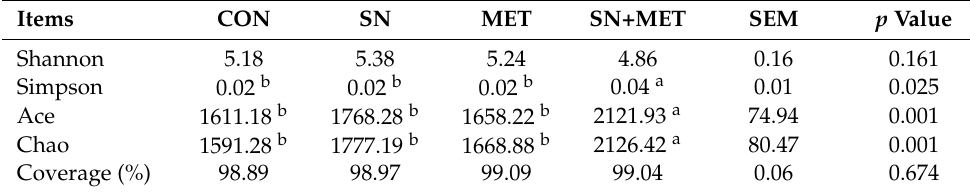
Table 5. Alpha diversity parameters across different treatment